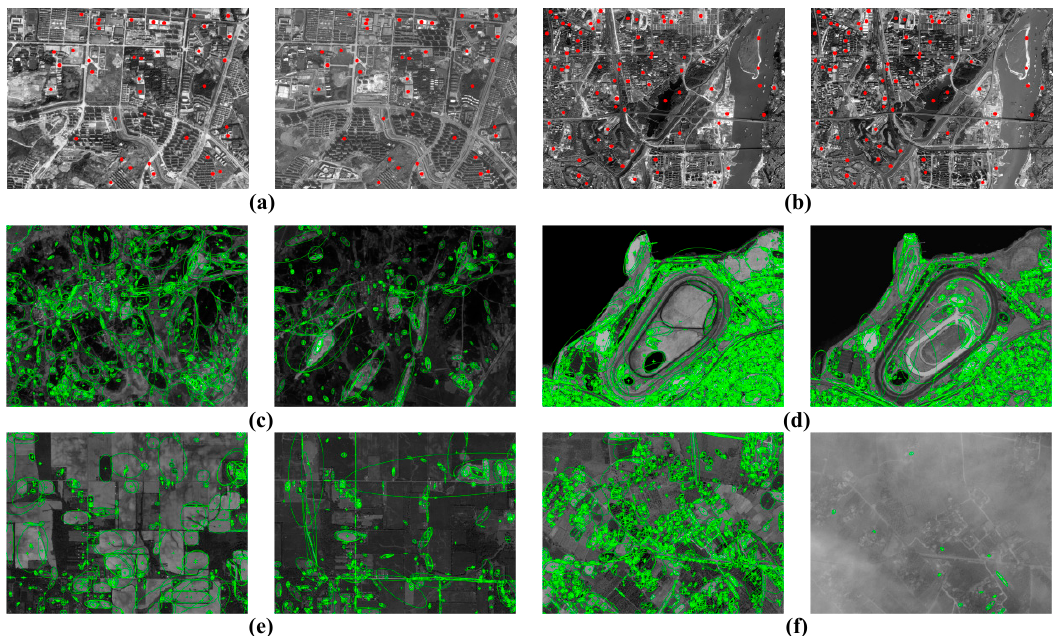
correct match is obtained for the image of Pair 6 (i.e., see Table 2).